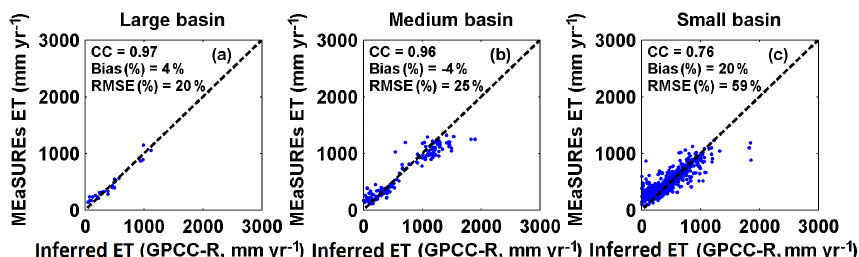
Figure 15. Validation of MEaSUREs ET estimates against inferred ET ( P − R ) over large (25), medium (169), and small (813) basins.